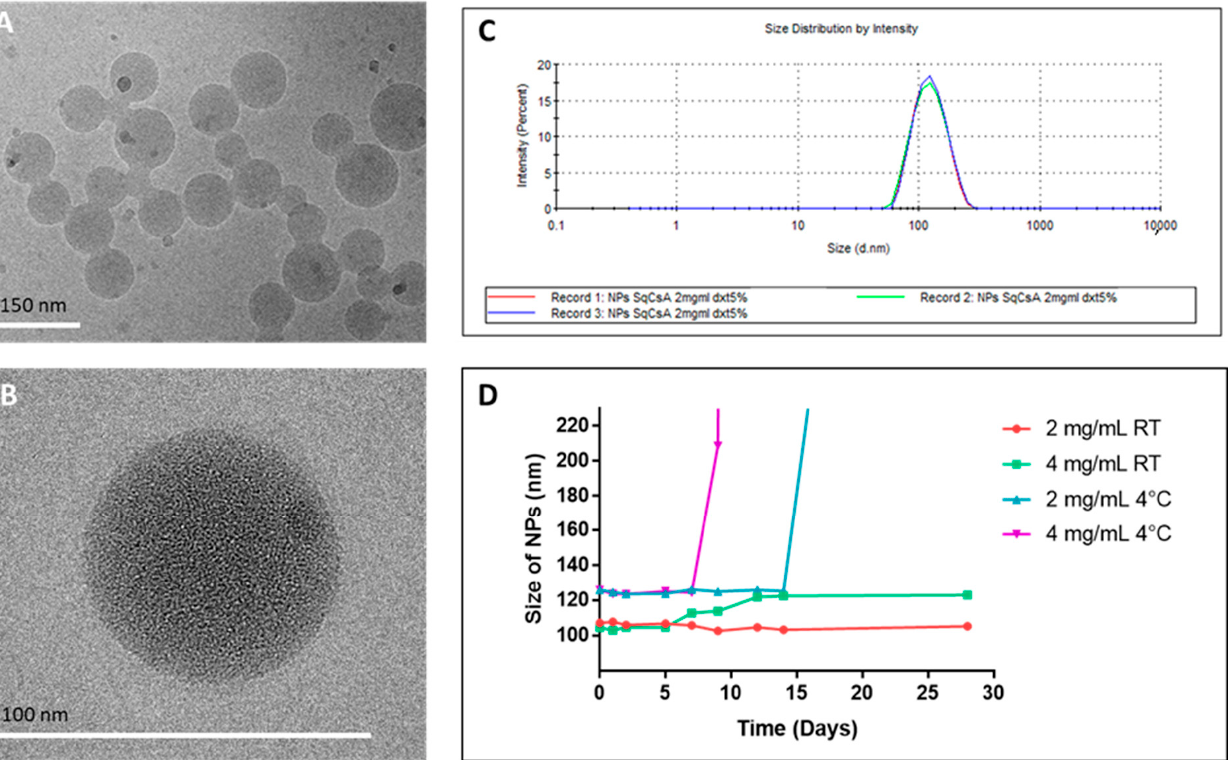
Figure 3. SqCsA nanoparticles (NPs) characterization by using cryogenic transmission electron microscopy (cryoTEM) ( A , B ) and dynamic light scattering (DLS) ( C , D ) of NPs suspensions. Stability assessment was performed for 28 days (D).